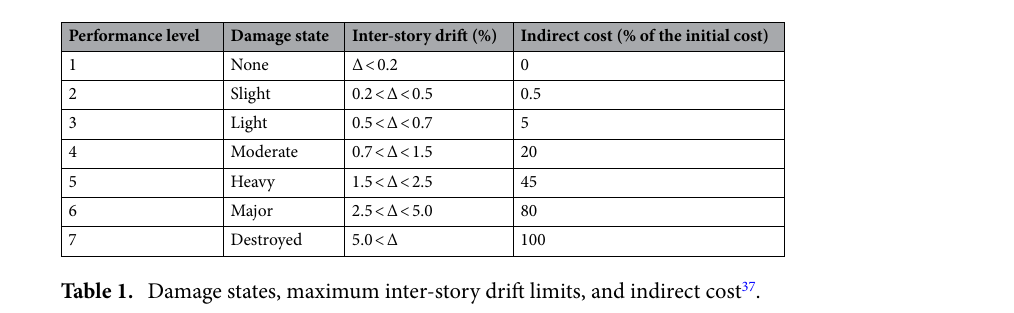
Table 1. Damage states, maximum inter-story drift limits, and indirect cost 37